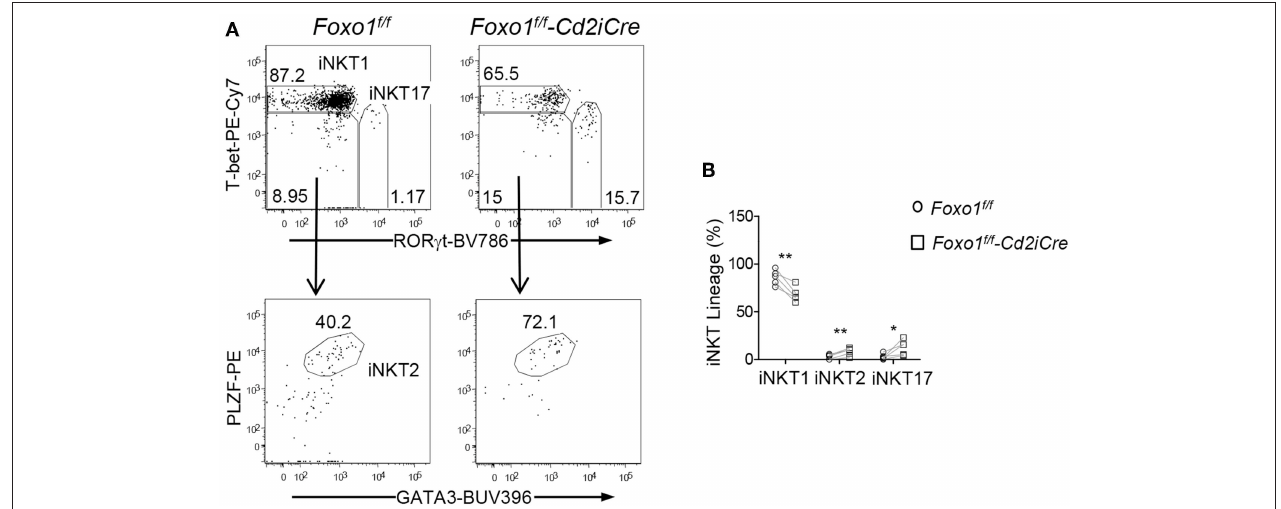
FIGURE 5 | Selective impairment of i NKT1 differentiation in Foxo1 deficient mice. (A) Top panels: T-bet and ROR γ t staining of thymic i NKT cells. Bottom panels: PLZF and GATA3 staining of ROR γ t − T-bet − i NKT cells. (B) Percentages of i NKT effector lineages. Data shown are representative or pooled from five experiments. Connecting lines indicate individual pairs of sex- and age-matched test and control mice in each experiment. One pair of mice was examined in each experiment. * p < 0.05; ** p < 0.01 determined by two-tail pair-wised Student t